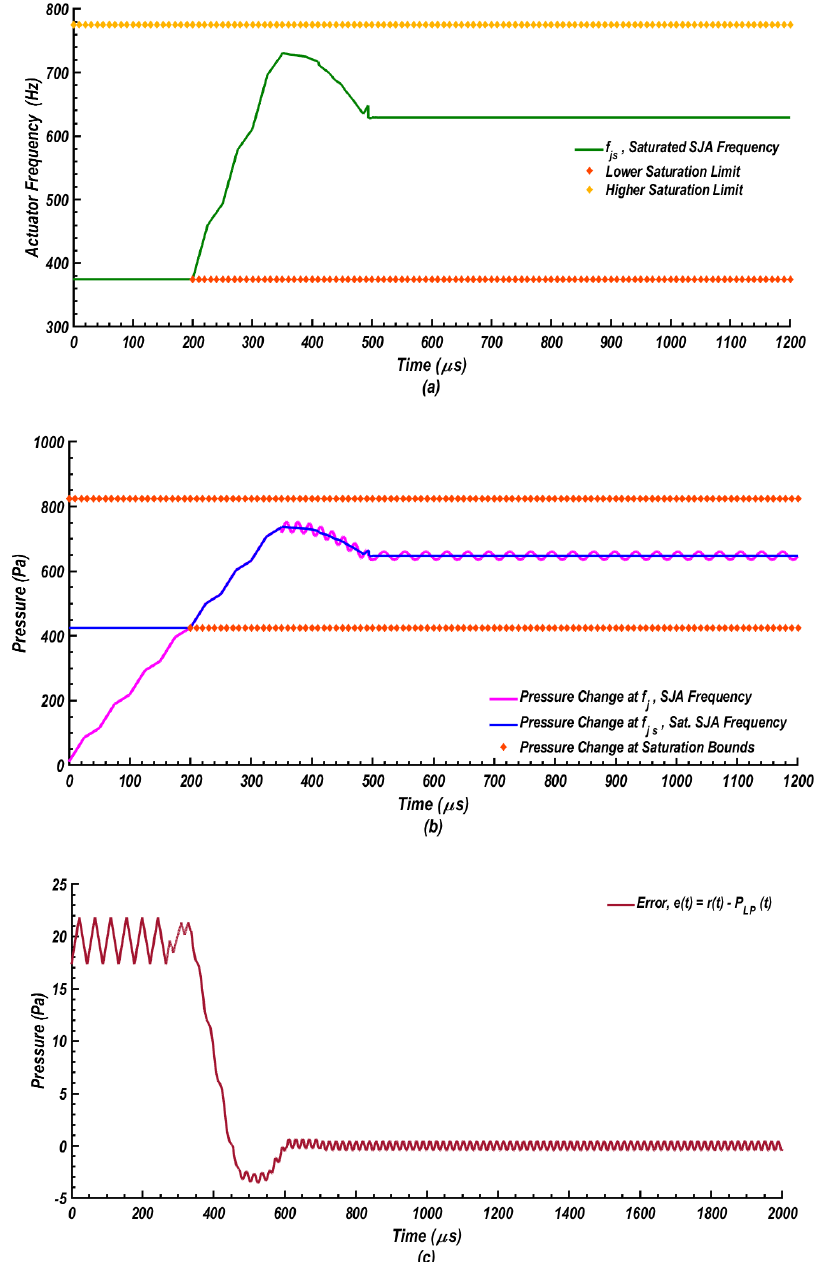
Figure 21. Closed-loop responses using a PI controller with KP = 3.27 and KI = 0.083. ( a ) Time response of saturated SJA frequency, f js , to step input (200 µ s required by integral e ff orts to compensate feedback errors.) ( b ) Time response of pressure signal at 30% chord location to step input of 20 Pa. (200 µ